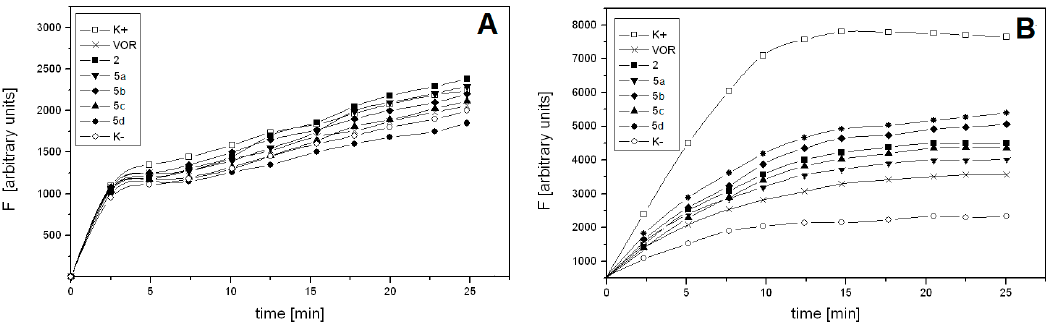
Figure 1. Time course of Rhodamine 6G e ffl ux from C. albicans Gu4 ( A ) or Gu5 ( B ) cells. Glucose-starved cells were preloaded with Rhodamine 6G (10 µ M) and 100 µ M VOR or one of the VOR salts, if